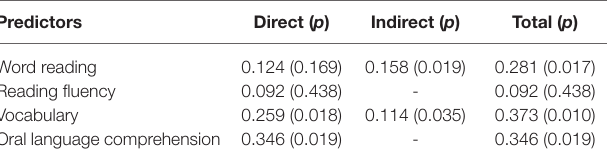
TABLE 3 | Standardized direct, indirect, and total effects of predictors on reading comprehension, in the extended SVR model. Predictors